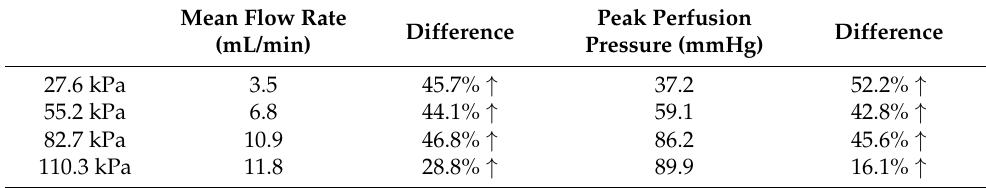
Table 4. Current Device Performance.